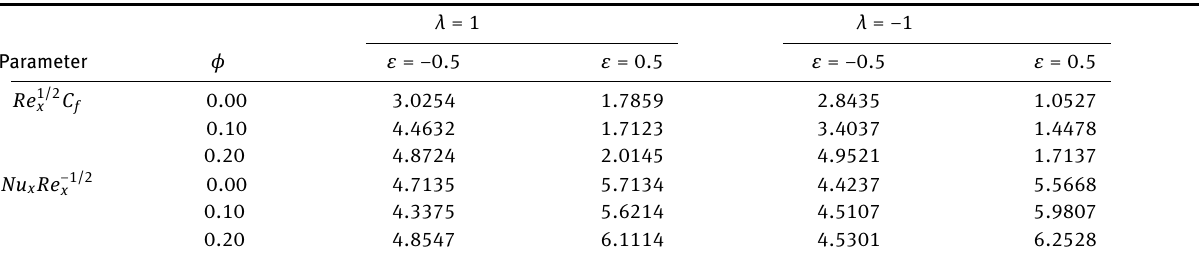
Table 6: The effect of the nanoparticle volume fraction on the skin friction coefficient and local Nusselt number for alumina-sodium algi- nate nanofluid with A = 0.5, M = 1, U = 0.5. w